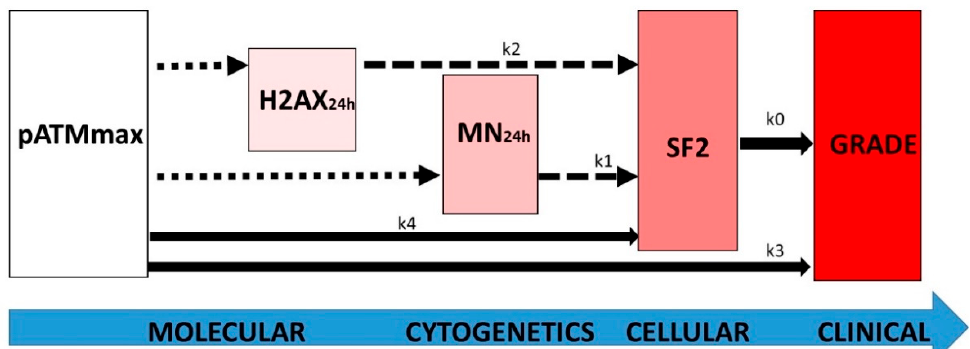
Figure 10. Schematic view of the link between the major radiosensitivity endpoints with the k coefficients of the differential equations described at the end of the Results chapter. The dotted, dashed, and full-line arrows represent complex, exponential, and linear laws, respectively.